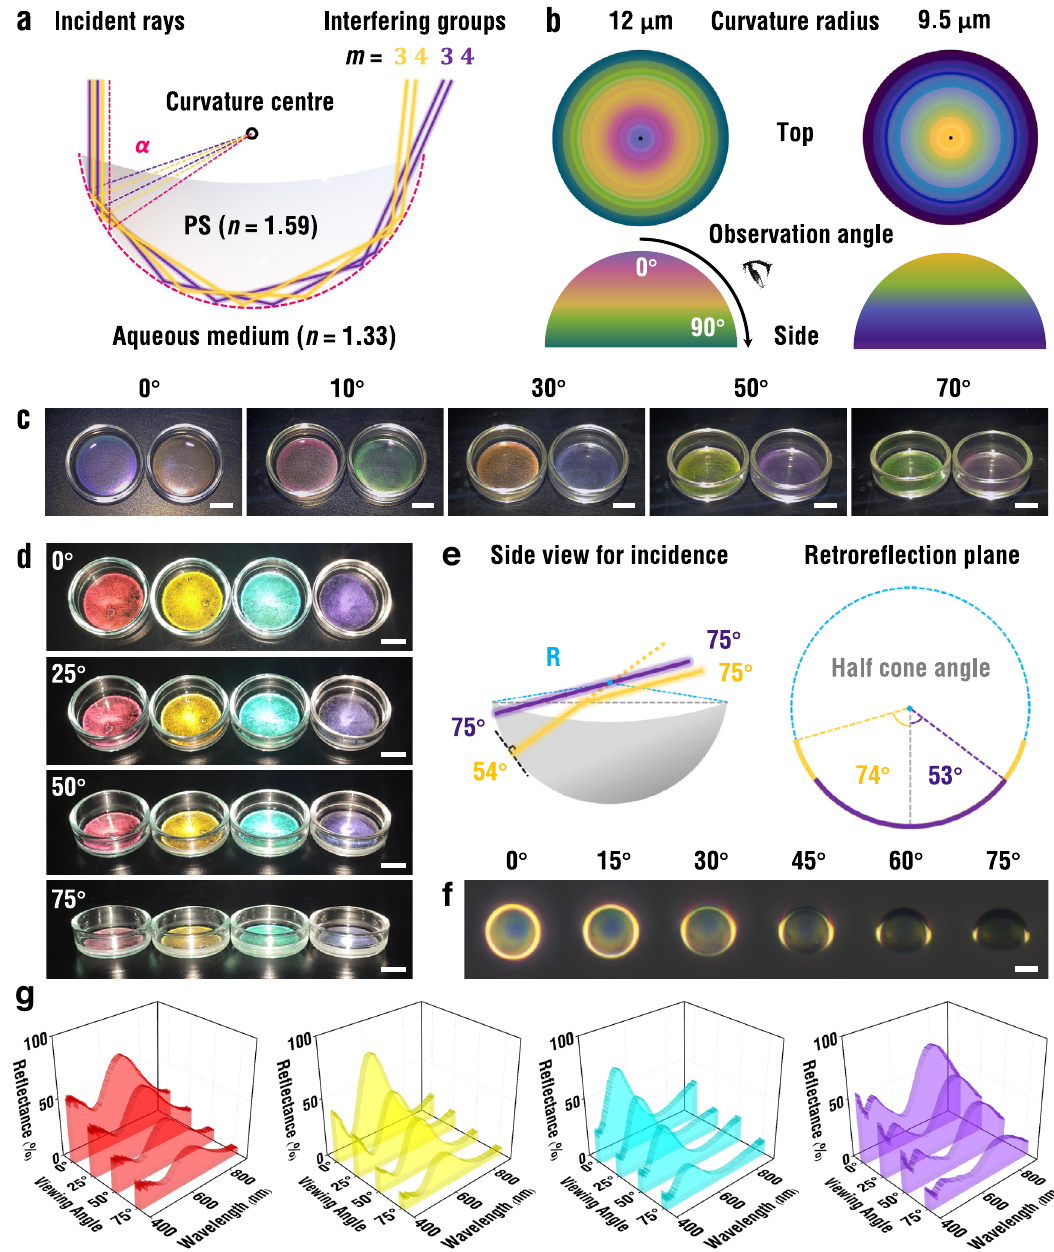
Fig. 2 | Structural colors from micro-crescents. a Illustration showing two dif- ferent pairs of light paths responsible for total internal re fl ection (TIR) and optical interference in the micro-crescent. b Top-view and side-view color maps for the curved interfaces with curvatureradii (CRs)of12 μ m and 9.5 μ m, where the colors are converted from the re fl ectance spectra calculated by a model previously reported. c Series of photographs showing the color change along with the observationanglefrom0°to70°underincidentlightnormaltothesuspensionsof micro-crescents with CRs of 15 μ m (left) and 12.5 μ m (right). Scale bar, 10mm. d Series of photographs showing the invariant colors with the observation angle